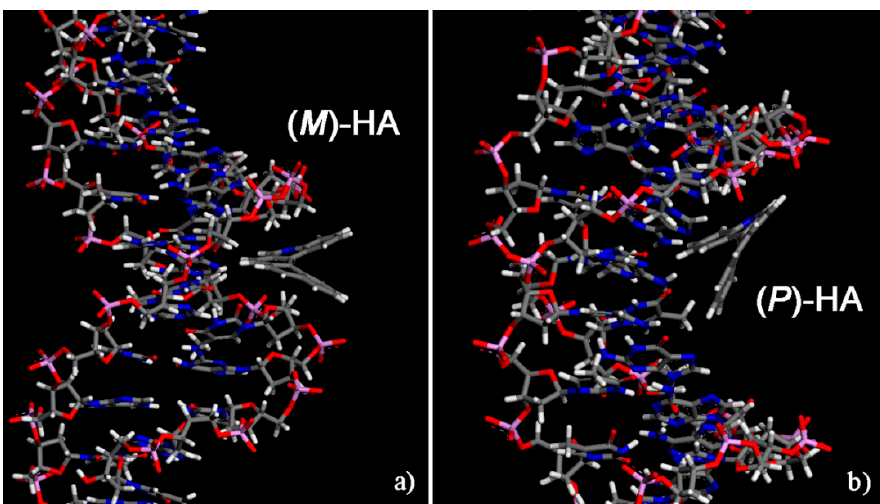
Figure 4. Optimized geometries of ( M )-5-Aza[5]helicene on the left ( a ) and ( P )-5-Aza[5]helicene on the right ( b ) after energy minimization of the conformation assumed by the system at the end of MD run lasting 10 ns. Color code: Carbon atoms are grey, the nitrogen blue, oxygens red, the phosphorus pink and hydrogens are white. The double strand DNA structure was slightly rotated to better show the two different sites of interaction.